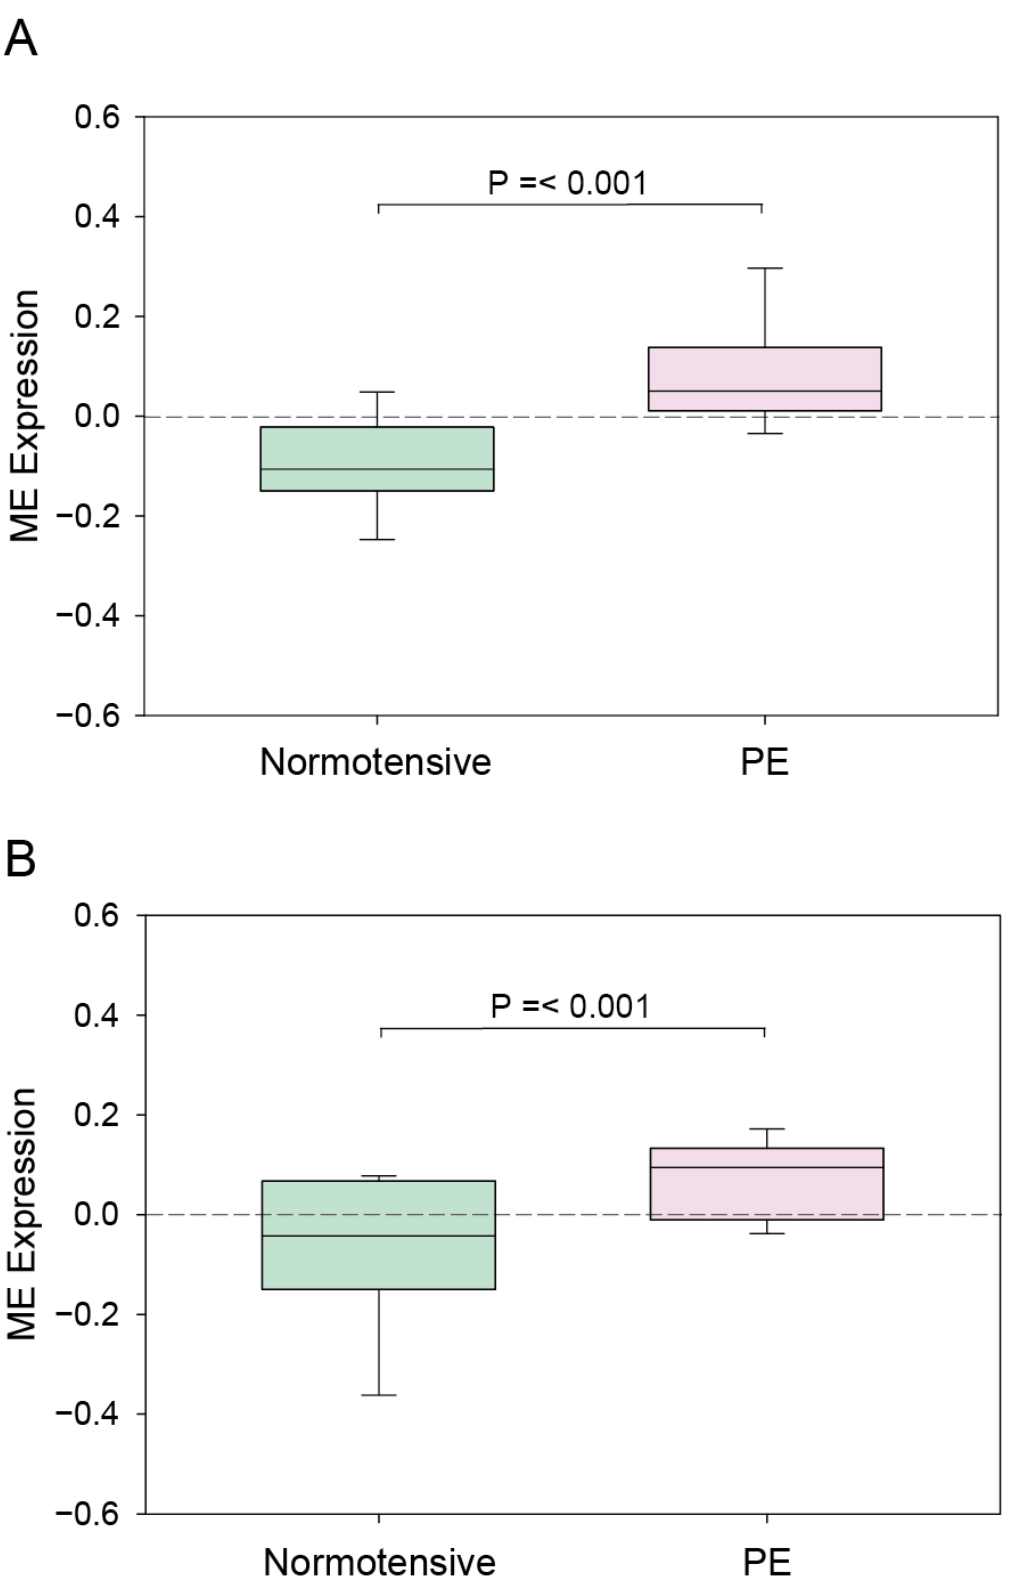
Figure 4. The module eigengene (ME) expressions of the cyan ( A ) and magenta ( B ) modules. Columns: mean values. Bars : SEM.